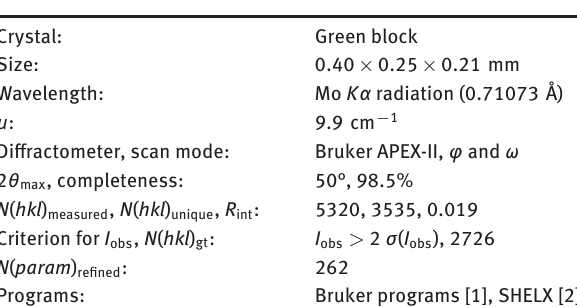
Table 1: Data collection and